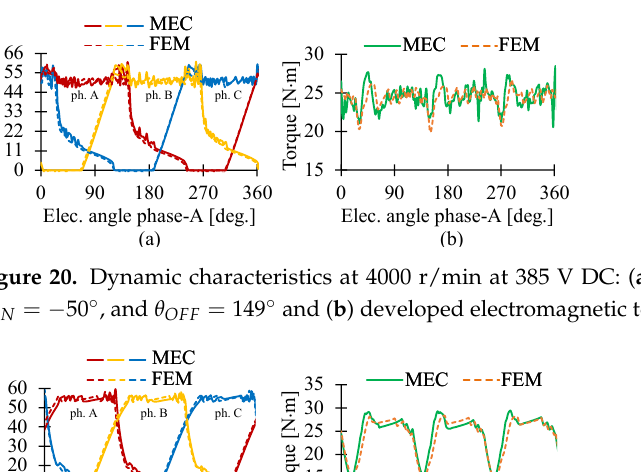
Figure 19. Dynamic characteristics at 2000 r/min at 385 V DC: ( a ) phase currents I ref = 52 A, θ ON = − 5 ◦ , and θ OFF = 165 ◦ and ( b ) developed electromagnetic torque.